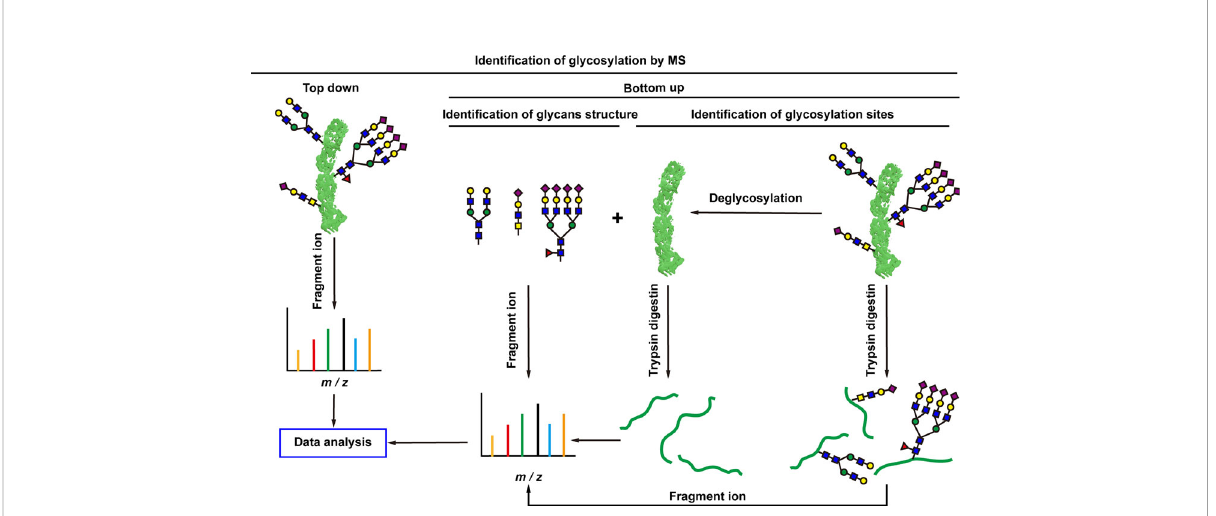
FIGURE 5 Mass spectrometry analysis of protein glycosylation. Top-down and bottom-up mass spectrometry approaches are used for protein glycosylation analysis. Top-down approach can directly assess the protein backbone and PTMs without any enzymatic digestion prior to MS analysis. Bottom-up approach fi rstly digests extracted proteins to generate peptides, and then the peptides are used for MS